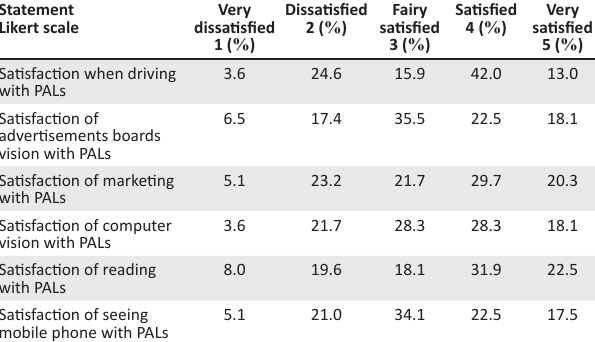
TABLE 1: Vision satisfaction rates with progressive addition lenses.